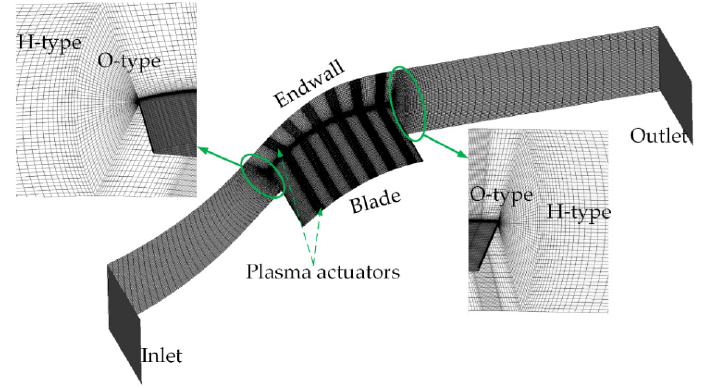
Figure 1. Calculation grid model.